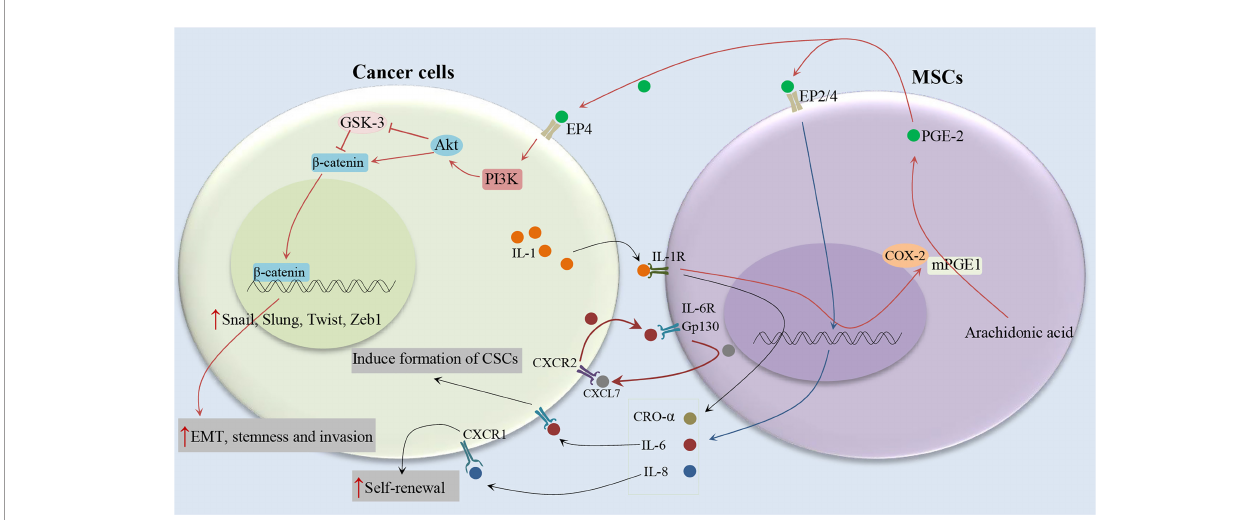
FIGURE 3 | Cytokine networks between MSCs and cancer cells and induction of CSC phenotype. Cancer cells stimulate the COX-2/mPGES-1/PGE 2 axis in MSCs by releasing IL-1. MSCs release PGE-2 in response to IL-1, PGE-2 in an autocrine fashion promote the expression of IL-8, IL-6, CXCL1, RANTES, and GRO- a , which together stimulate the formation of CSCs (19 –